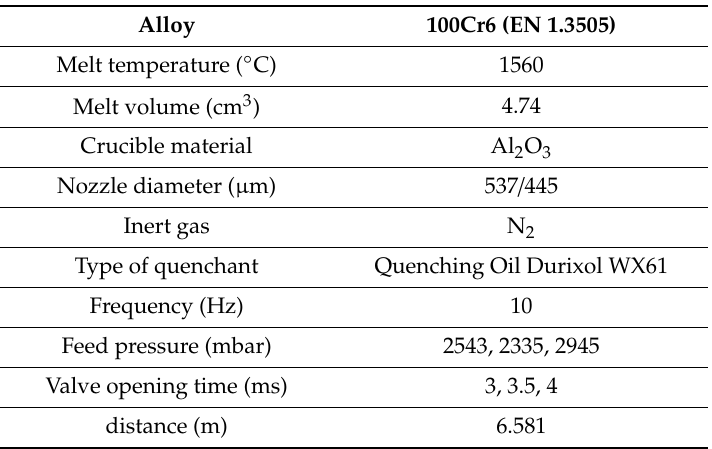
Table 1. Experimental Parameters of the two experiments.